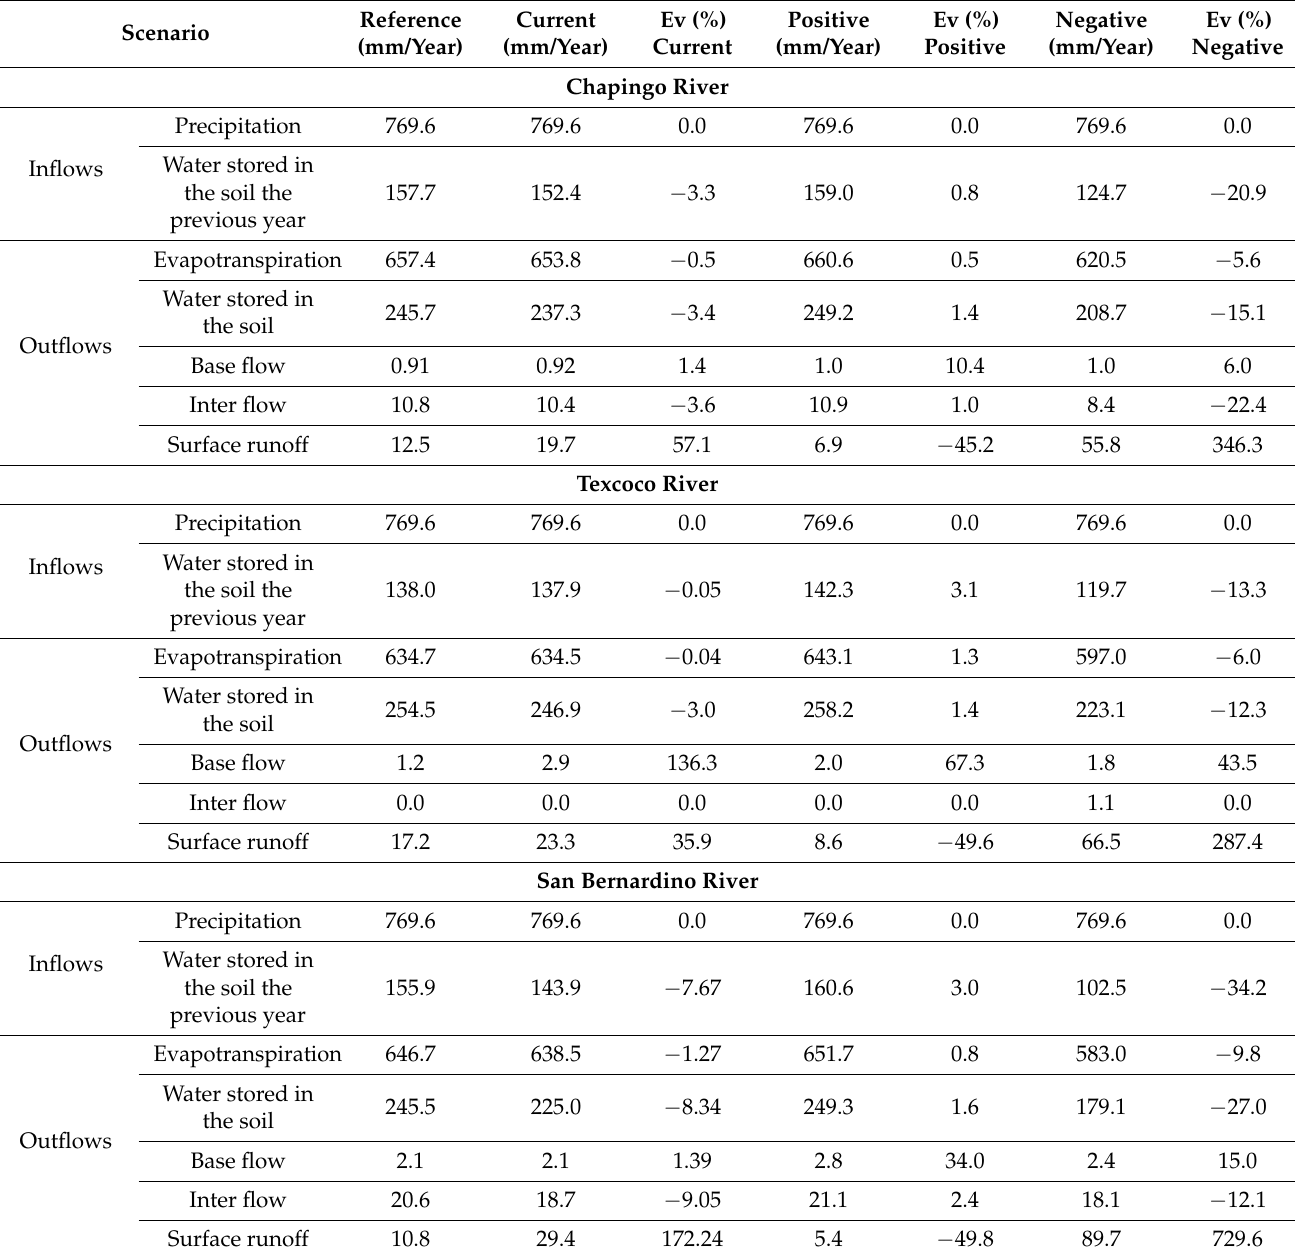
Table 8. Inflow and outflow of the hydrological balance in catchments where the cover of the temperate forest predominates in the Chapingo River, Texcoco River, and San Bernardino